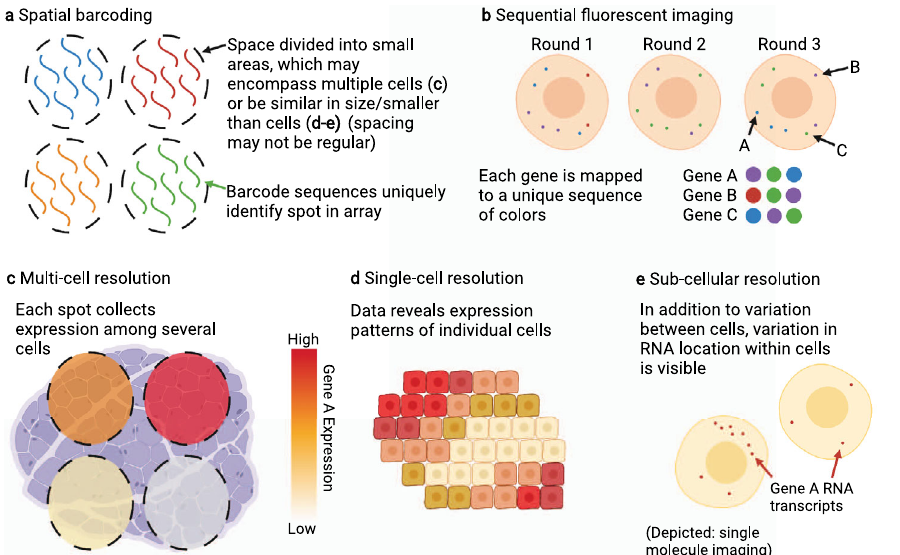
Fig. 1 Spatial Transcriptomics Data: Collection and Resolutions. ST data can be collected with various methods and resolutions. a Illustration of spatial barcoding, in which spatially-identi fi ed barcodes are arranged and then used to tag RNA molecules in tissue. Compare with c , but note these methods are not restricted to multi-cell resolution. b Illustration of sequential fl uorescent imaging, where RNA molecules are sequentially tagged with different color fl uorescent probes and the color sequences are used to identify RNA species. In general, this data is collected at sub-cellular resolution, as show in e , but is frequently combined with cell segmentation to create single-cell data, as in d . c Multi-cell resolution spots, in which measured expression at one spatial location is collected across a number of possibly heterogeneous cells. d In single-cell resolution data, each spatial location corresponds to one cell. This allows for spatial analysis of cell identity and a single-cell understanding of tissue structure and cell-cell communications. e One type of sub-cellular resolution data is single-molecule imaging. Note the presence of information both in the number of distinct RNA molecules of one type in a cell, and also the localization of those molecules within the cell. Sub-cellular resolution data may be combined with cell segmentation to produce single-cell data to facilitate corresponding